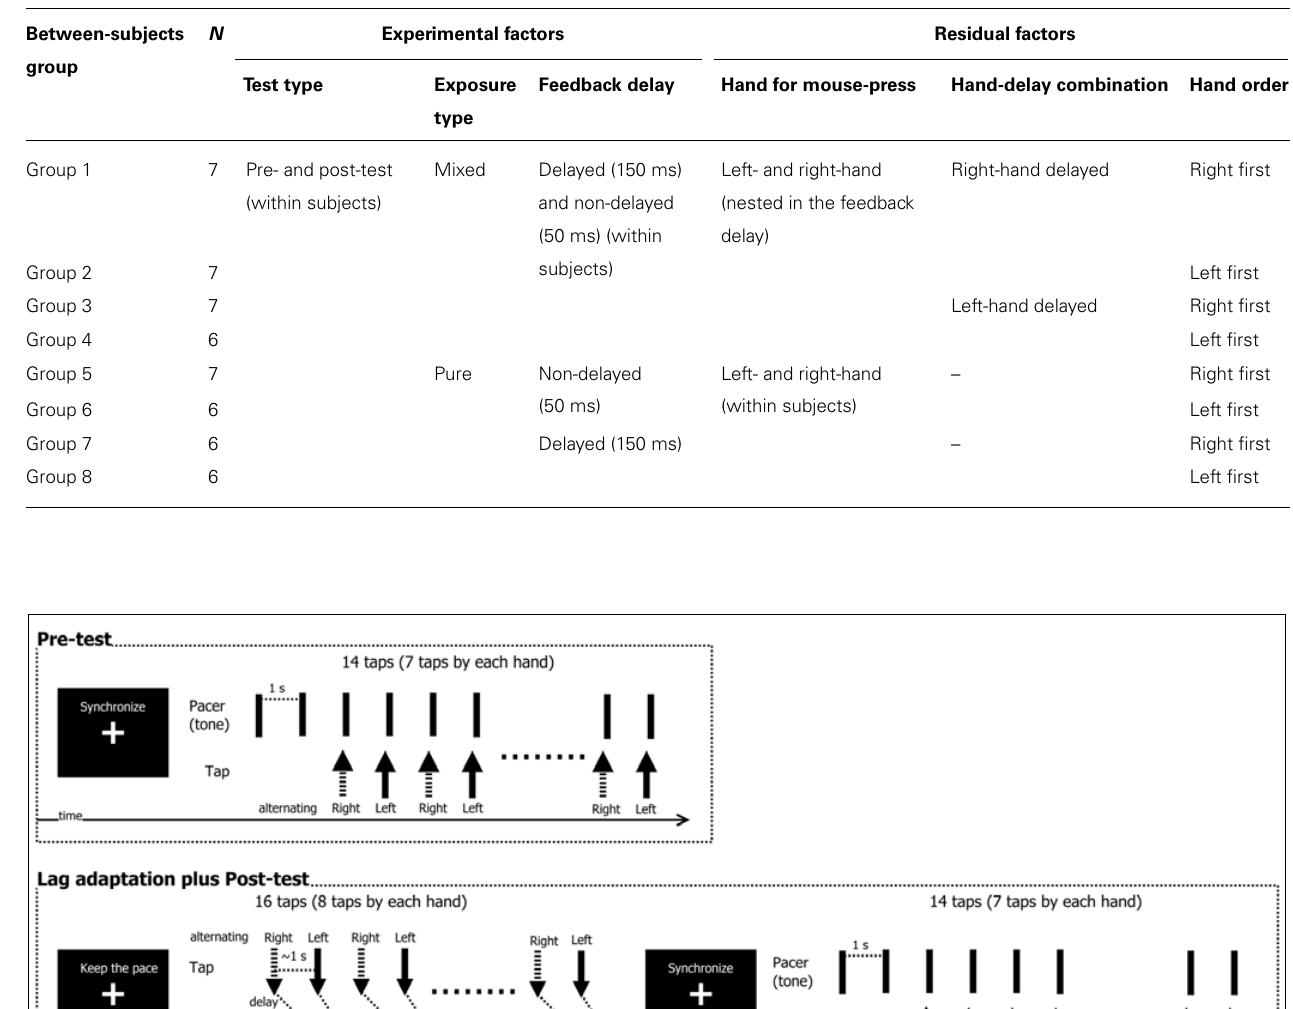
Table 1 | Experimental design and factors.